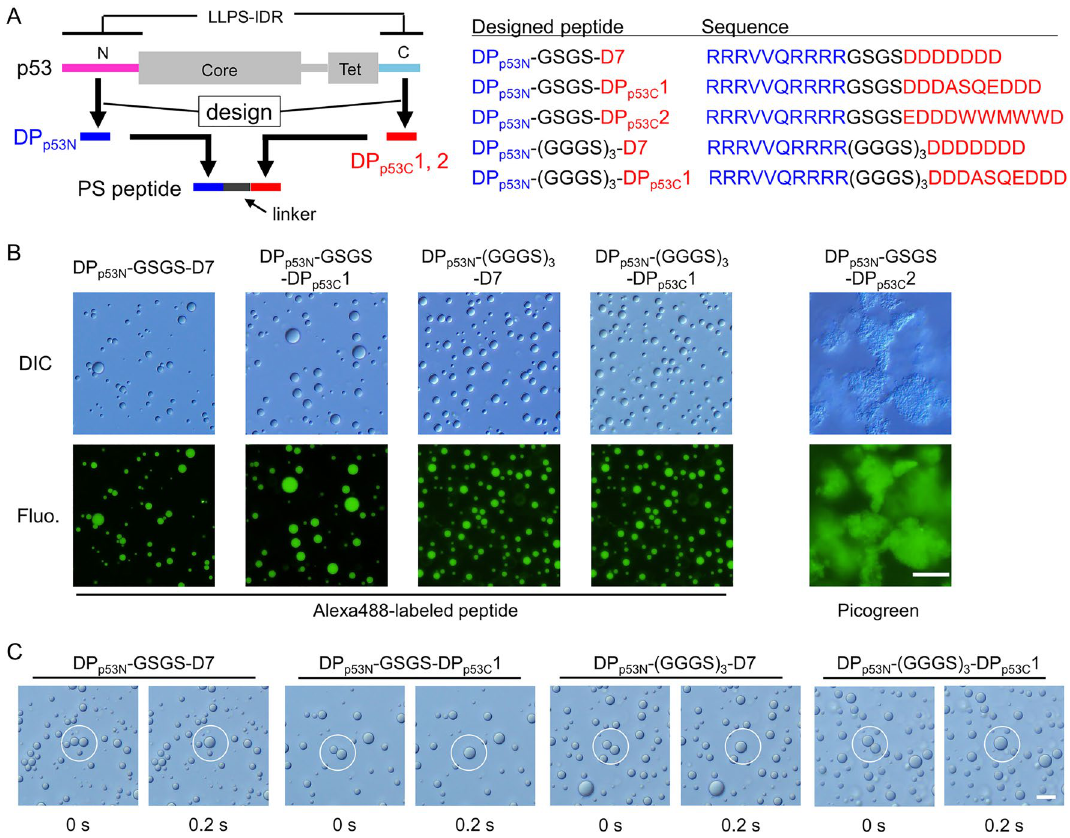
Figure 2. Design scheme and experimental verification of artificial PS peptides from PS protein p53. ( A ) The design scheme and peptide sequences designed based on the p53 sequence. N, core, Tet, and C represent the N-terminal, core, tetramerization, and C-terminal domains of p53, respectively. Large boxes represent folded regions, whereas thin lines represent disordered regions. Complementary peptide fragments (blue and red) were designed based on two LLPS-relevant IDRs (pink and light blue) of p53 and were then connected by a linker (black). ( B ) DIC and fluorescence images of the solution containing designed peptides in the concentration range of 0.9–1.8 mM in the absence of salt at pH 7.0. Alexa488-labeled peptide at 0.1 μM was added to confirm high concentrations in liquid droplets. Picogreen was used as an amyloid-sensitive probe. ( C ) Typical fusion snapshots of two droplets (white circles) in the solution containing 1 mM designed peptide in the absence of salt at pH 7.0. Scale bars in panels B and C denote 20 and 10 μm, canceling the positive charges of DP p53N and interacting with DP p53N of other molecules electrostatically. Fur- thermore, two PS peptide candidates, DP p53N -(GGGS) 3 -DP p53C 1 and DP p53N -(GGGS) 3 -D7, were designed to test the effect of the linker length. Sequence analysis of the PS peptide candidates and natural proteins revealed that the maximum sequence identities ranged from 41 to 58% for the full-length designed peptides, but were at least 70% for the complementary binder peptides (Supplementary Table S1). Differential interference contrast (DIC) microscopy confirmed that these peptides (0.9–1.8 mM) underwent phase separation in 25 mM HEPES and 0.5 mM EDTA at pH 7.0 (Fig. 2B). To prevent the melting of clusters on the coverslip surface, 2-methacryloyloxyethyl phosphorylcholine (MPC) polymer coating was used 36,37 (Sup-